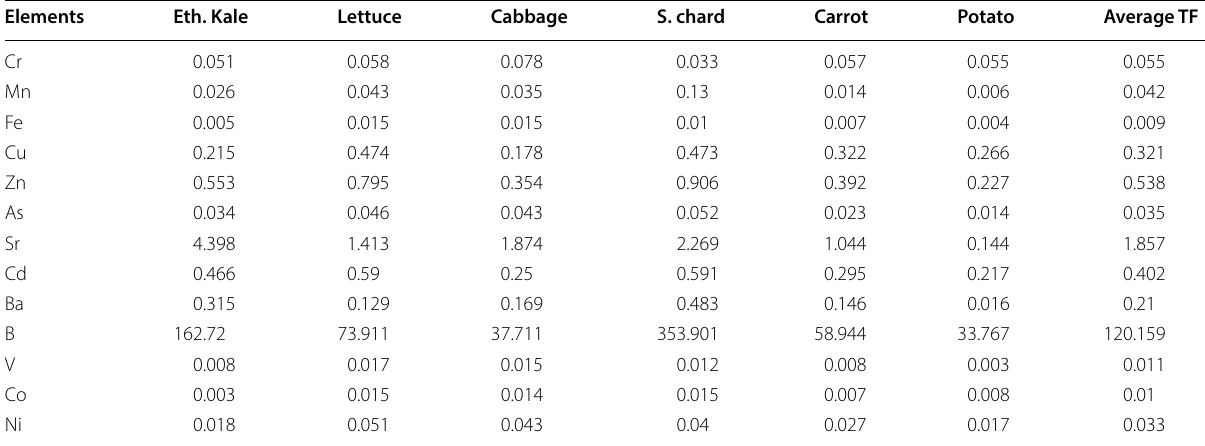
Table 4 Bioconcentration factors (BCF) of PTEs from soil to vegetables Elements Eth.